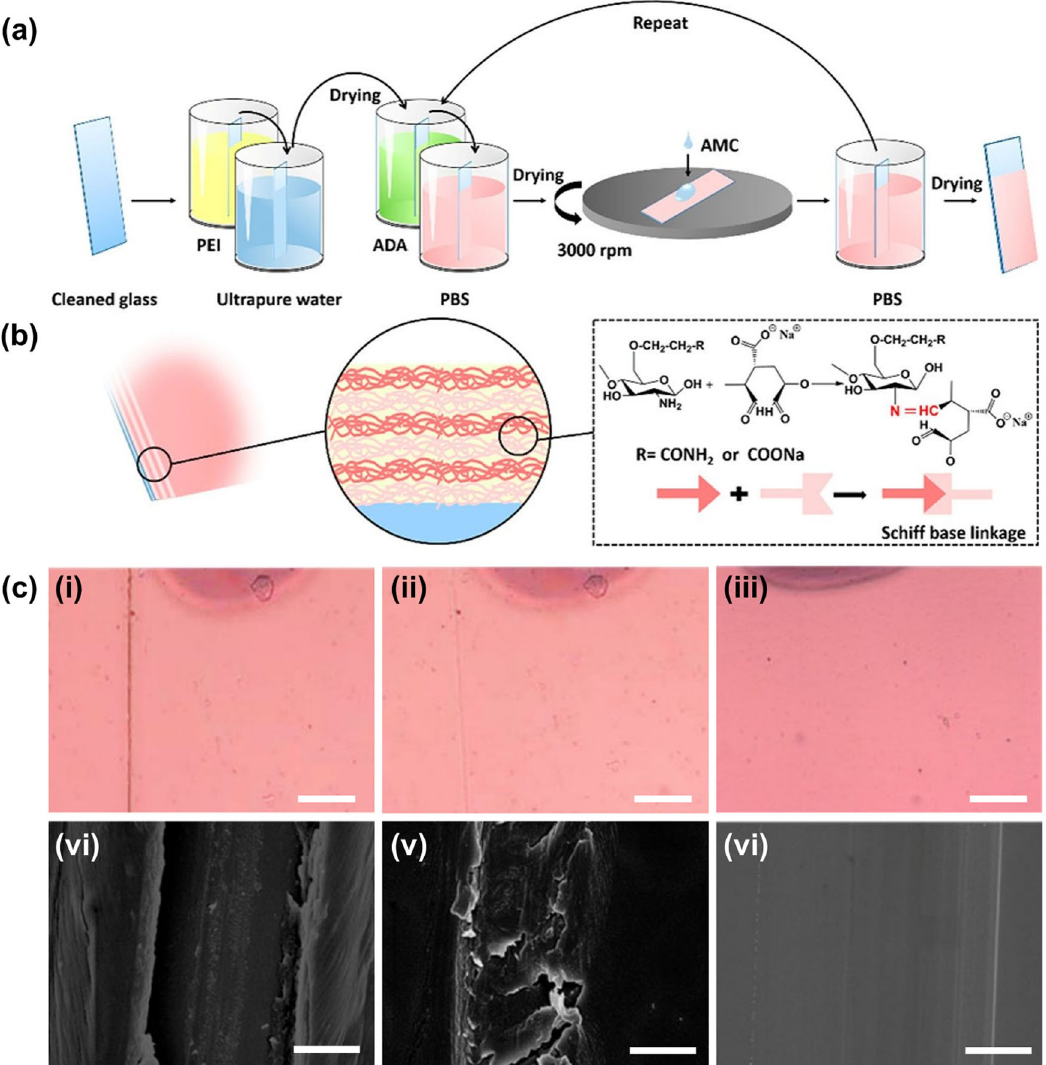
Fig. 1 Fabrication and self-repair of the ADA/AMC fi lm. a A schematic diagram illustrating the process of ADA/AMC fi lm preparation; b Mechanism of formation of the Schiff base linkage; c (i – iii) Microscopic and (iv – vi) SEM images of the ADA/AMC fi lm exhibiting self-healing: (i, iv) fresh cut, (ii, v) self-healing for 1 min, and (iii, vi) self-healing for 2 min. The fi lm has undergone six cycles of deposition. The scale bar in (i), (ii) and (iii) represents 100 µm. The scale bar in (iv), (v) and (vi) represents 5 µm. Reproduced from 48 with permission from American Chemical